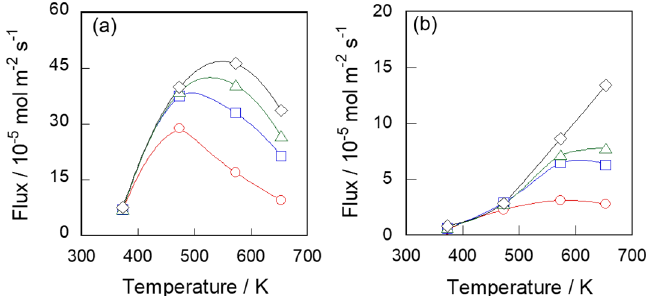
Figure 3. Membrane temperature dependency of 2-methylpentane fluxes through ( a ) S-1 S and ( b ) S-1 M . Partial pressures of 2-methylpentane are at ○, 10; □, 25; ▵ , 35 and ◊, 51 kPa.